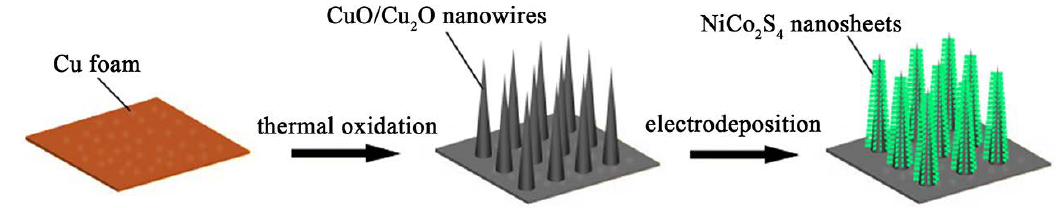
Figure 1. Schematic illustration of the CuO/Cu 2 O@NiCo 2 S 4 core-shell nanowire arrays on Cu foam. Typical XRD patters of the CuO/Cu 2 O and CuO/Cu 2 O@NiCo 2 S 4 -4 samples are given in Figure